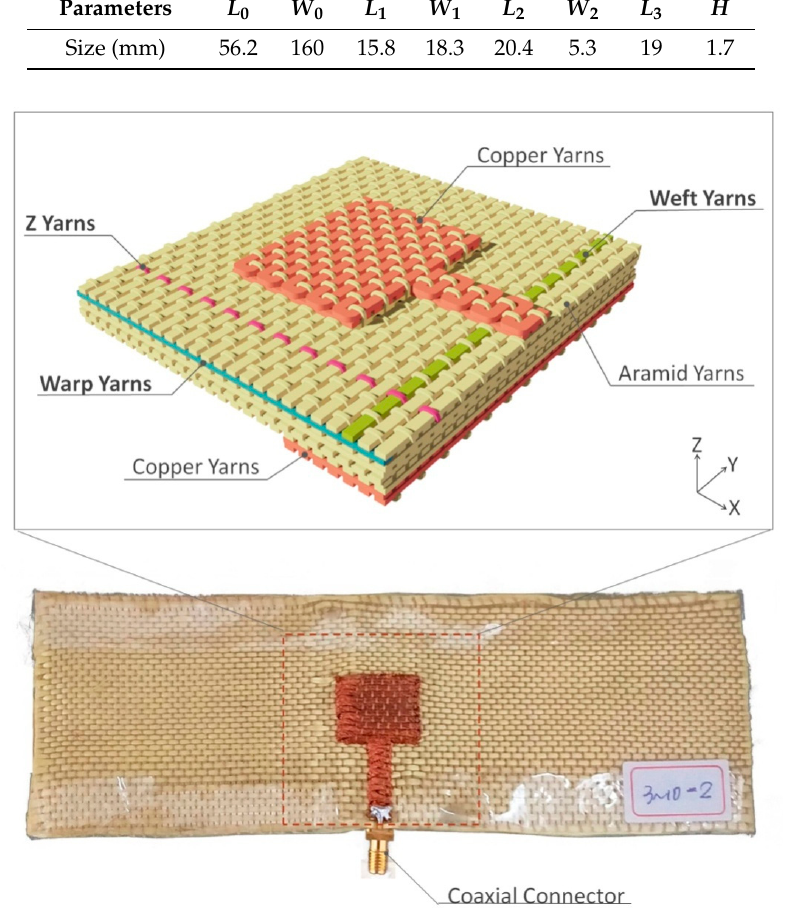
Figure 2. The photograph and woven structure of the proposed antenna.